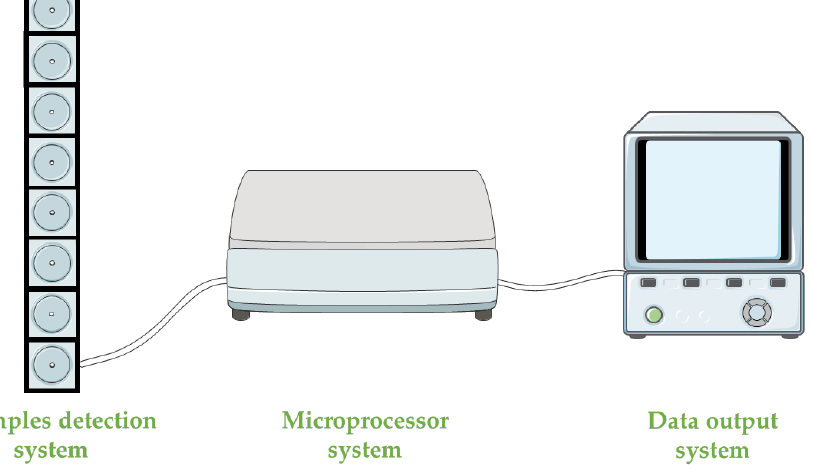
Figure 3. Schematic diagram of the polypyrrole probe, deposited on the polyimide surface to a pie- zoelectric quartz crystal in multi-channel series (PPY-MSPQC system).